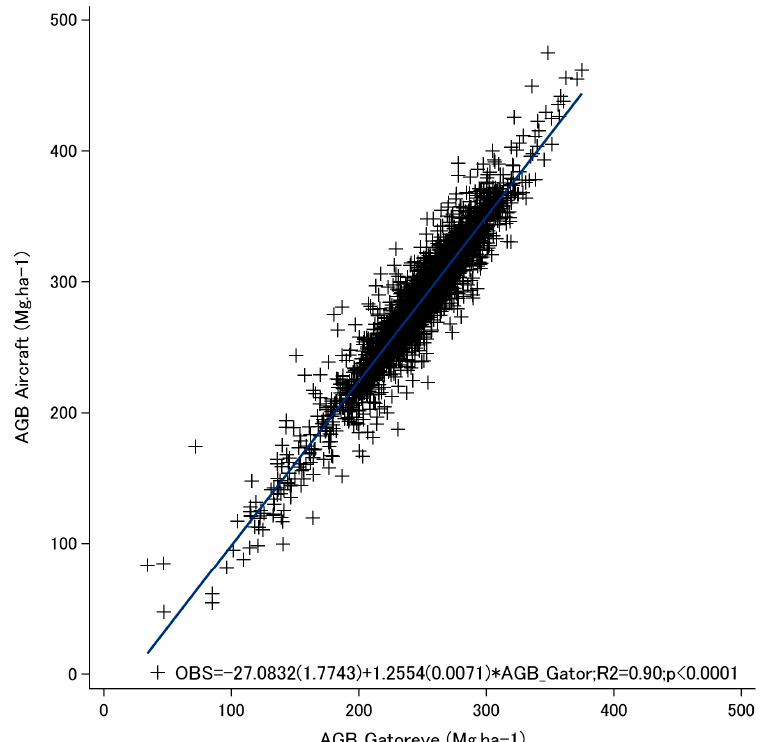
Figure 8. Predicted AGB across the entire landscape for the aircraft and GatorEye predictive models correlation: Aircraft: -529.761+(2.536*HMODE)+(23.115*H95TH), R 2 = 0.79, RMSE = 19.3 and GatorEye: correlation: Aircraft: − 529.761 + (2.536 × HMODE) + (23.115 × H95TH), R 2 = 0.79, RMSE = 19.3 and -355.4877+(19.794*H90TH), R 2 = 0.65, RMSE = 24.87) and GatorEye: -418.01+(7.2625*HMODE)+( GatorEye: − 355.4877 + (19.794 × H90TH), R 2 = 0.65, RMSE = 24.87) and GatorEye: − 418.01 + (7.2625 × 24.2363*H95TH)+(-535.1370*CRR), R 2 = 0.77, RMSE = 20.16. Numbers in parentheses are the standard HMODE) + ( 24.2363 × H95TH) + ( − 535.1370 × CRR), R 2 = 0.77, RMSE = 20.16. Numbers in parentheses are the standard errors for each coe ffi